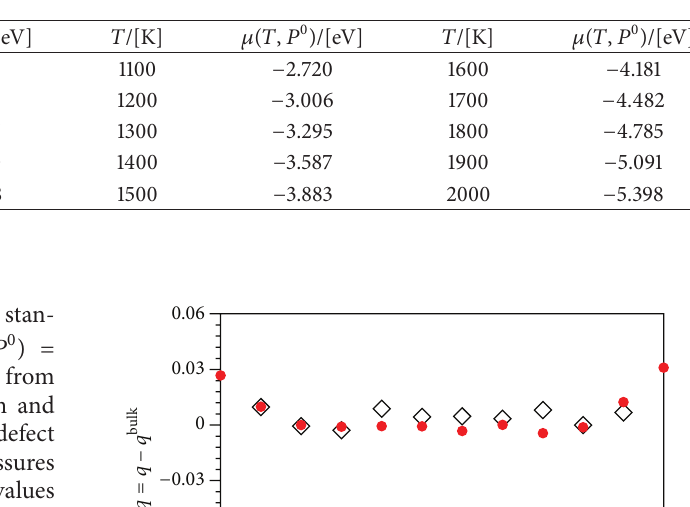
Table 1: The chemical potential of O as a function of the temperature. The entropy and enthalpy changes are taken from the JANAF thermochemical tables at 𝑃 0 = 0.1 atm [16].